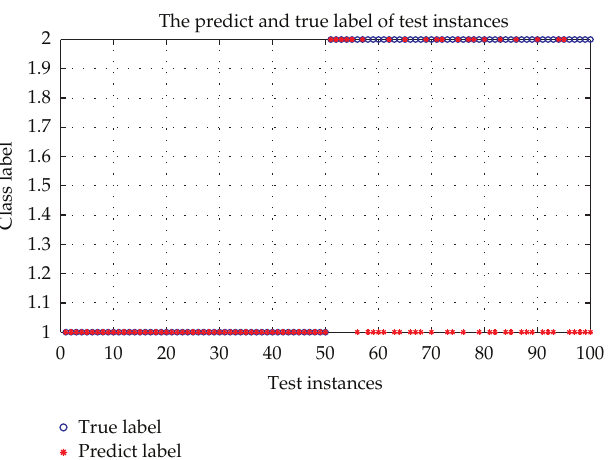
Figure 5: NLModel prediction result.